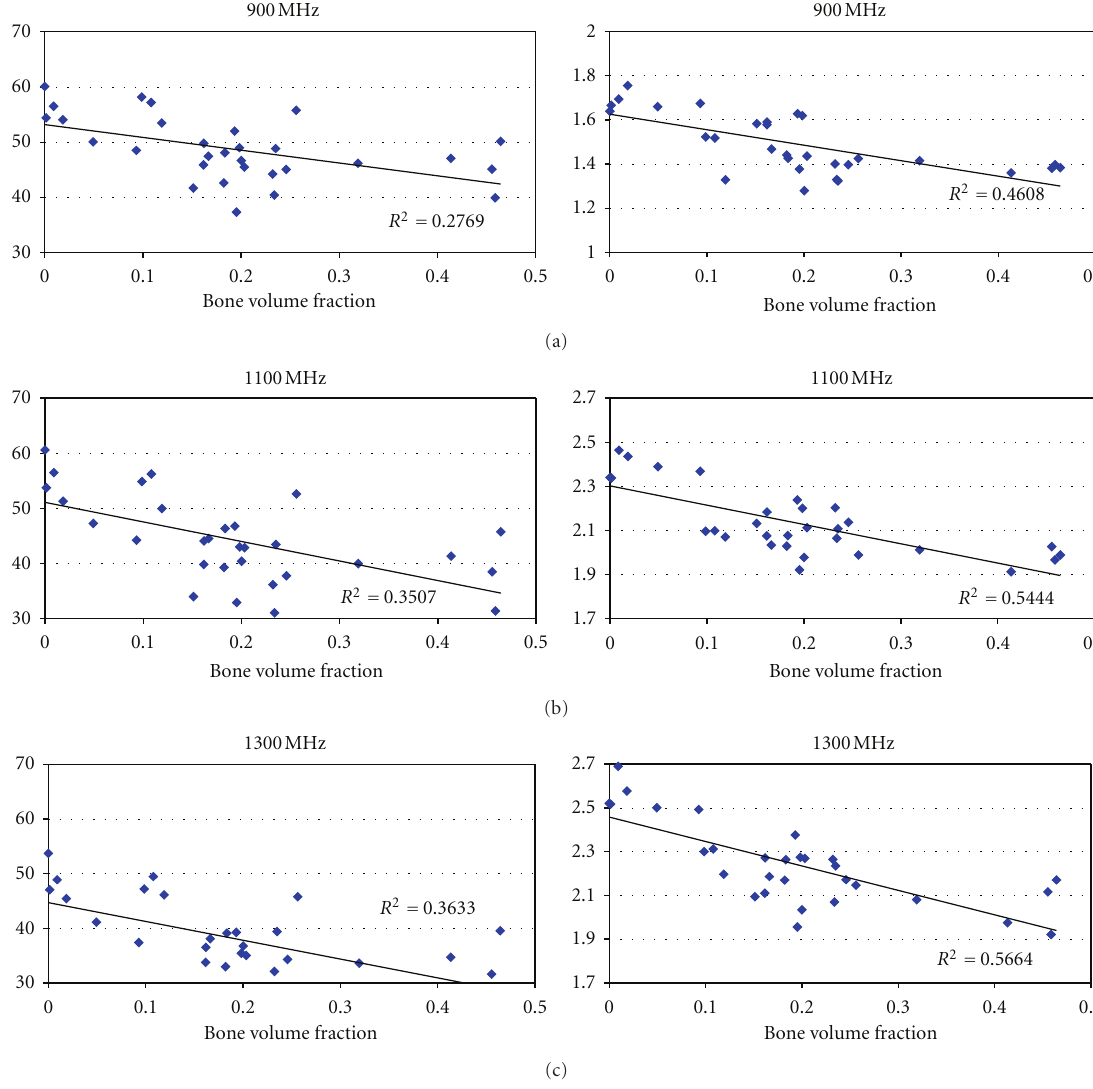
Figure 8: Scatter plot of dielectric properties versus bone volume fraction for saline-saturated bone specimens for di ff erent frequencies ( n = 30).